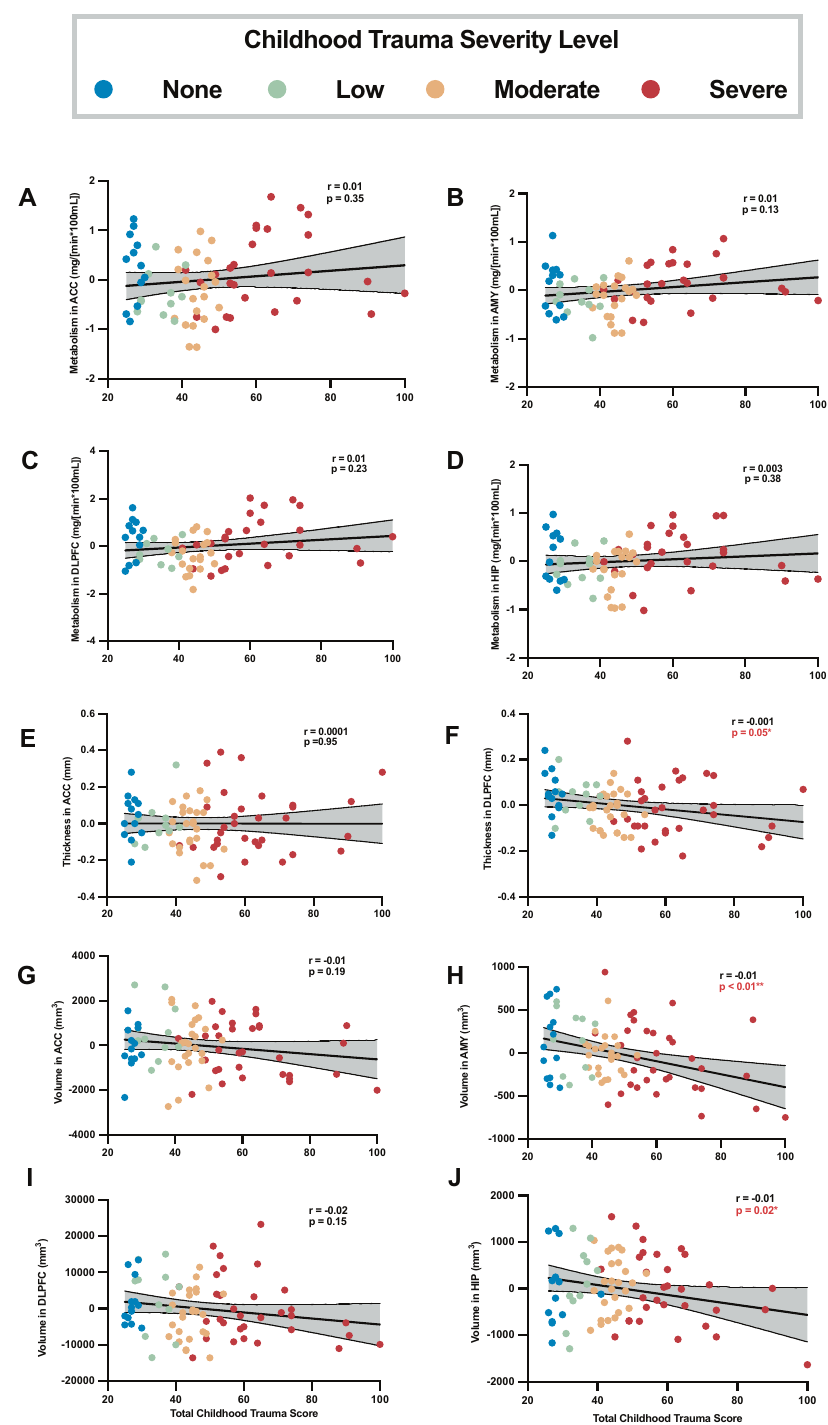
Fig. 1 Scatterplots of the residual values calculated from regional metabolism, thickness, and volume versus total Childhood Trauma Questionnaire (CTQ) score. Residual values from multiple regression analysis of brain volume/thickness/metabolism covarying for age, age 2 , and sex are displayed on the vertical axis. The colors represent the discrete categories of childhood trauma (none, low, moderate, severe) as de fi ned in Table 1. The regression line represents the line of best fi t. The lines surrounding the gray shaded area represent the 95% con fi dence interval. ACC Anterior Cingulate Cortex ( A , E , G ), AMY Amygdala ( B , H ), DLPFC Dorsolateral Prefrontal Cortex ( C , F , I ), HIP Hippocampus ( D , J function exists within each region. Thickness and metabolism were correlated in the DLPFC (Fig. 2A, p < 0.001). Thickness and/or volume in the other regions were not signi fi cantly correlated with metabolism in those regions.